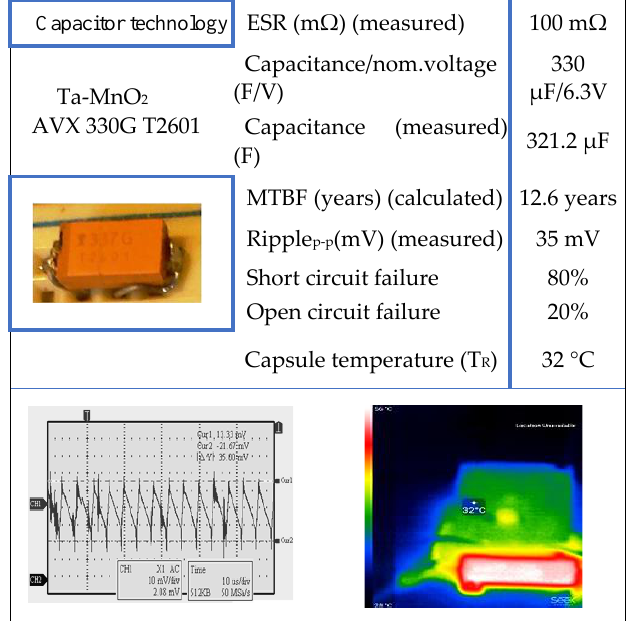
Figure 8. Data taken from measurement, photo of capacitor Ta-MnO 2 type AVX 330G T2601 as DUT (left –center), the actual ripple’s waveform (left) and surface capacitor’s temperature which is required in reliability calculations (right).